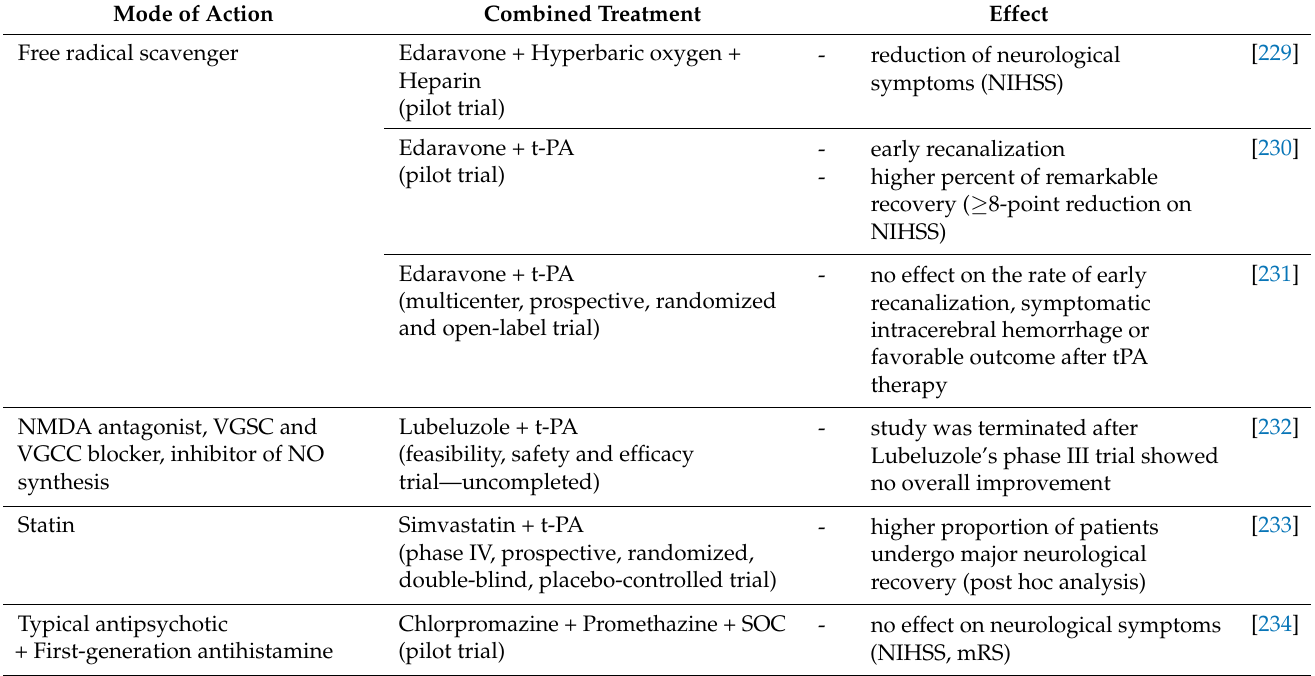
Table 3. Combined treatment therapies with the use of NO-related compounds in clinical trials. SOC—standard of care. Mode of Action Free radical